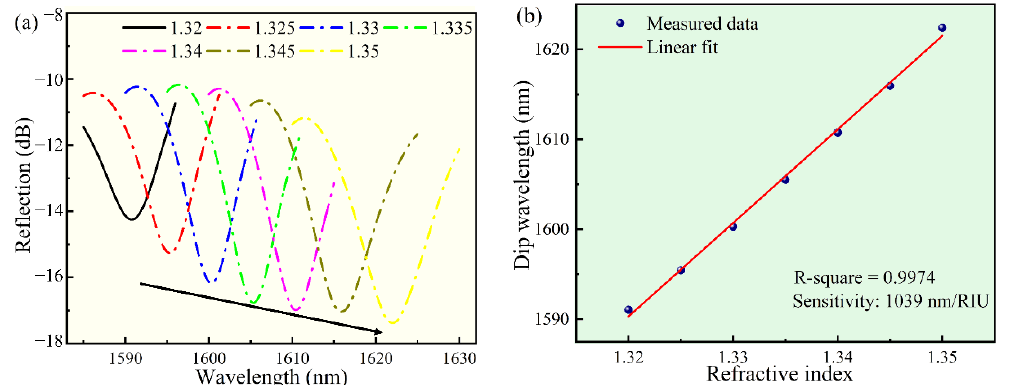
Figure 5. The response of the sensor to various RI solutions, in the wavelength range of 1585–1630 nm. ( a ) The dip wavelength shift of the reflectance spectrum of the sensor. ( b ) The corresponding relationship between the dip wavelength and the RI.